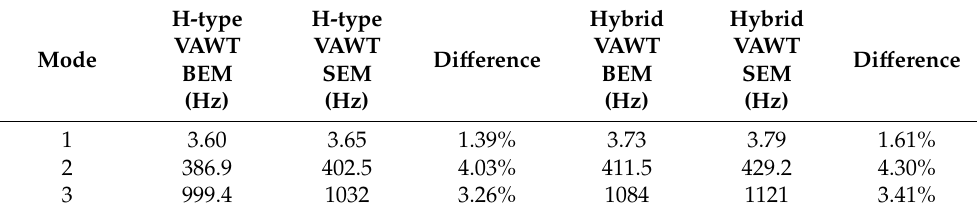
Table 12. Comparison of the first three natural frequencies of the 1 m-mast H-type and hybrid VAWTs from their SEMs that correspond to their X-Y planar motions and the first natural frequencies of the two VAWTs from their BEM.